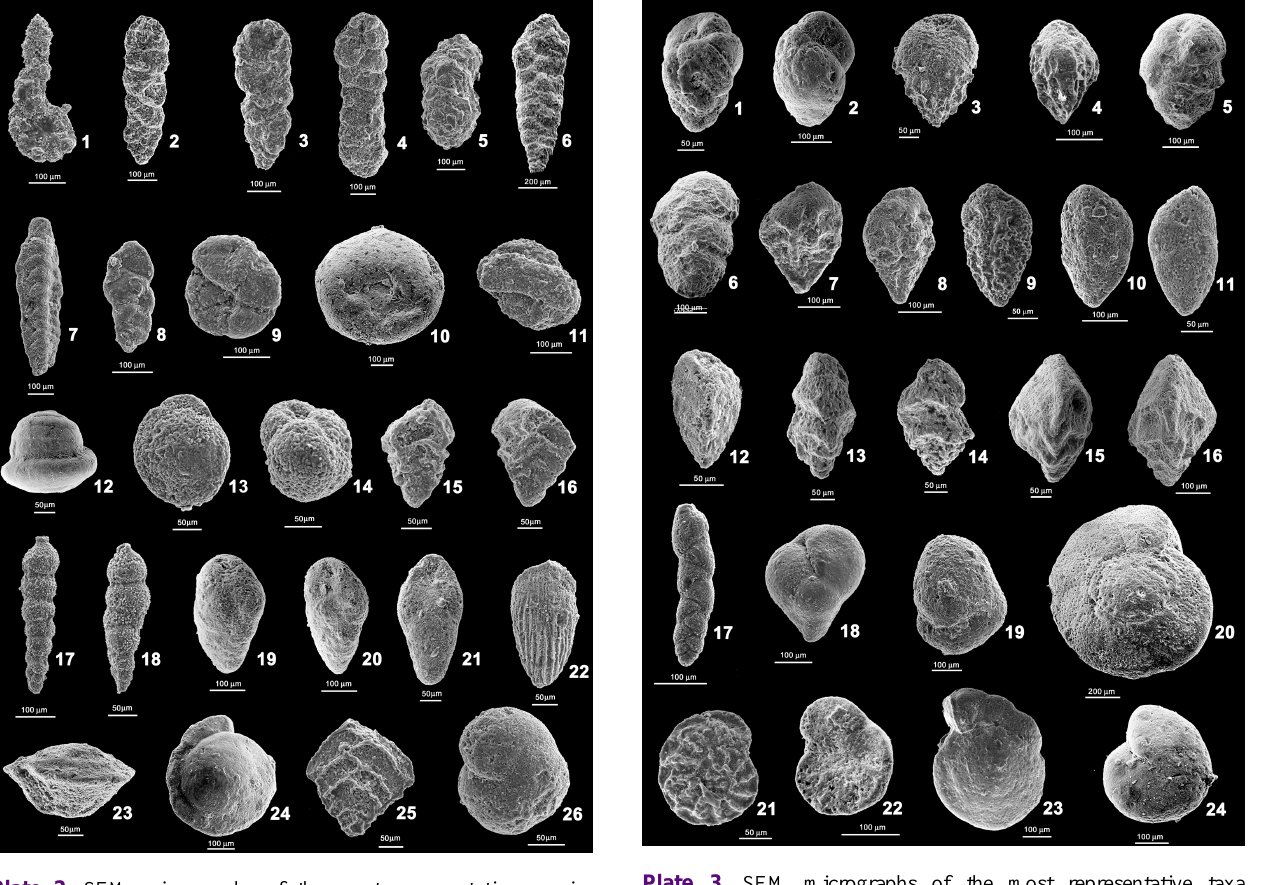
Plate 2. SEM micrographs of the most representative